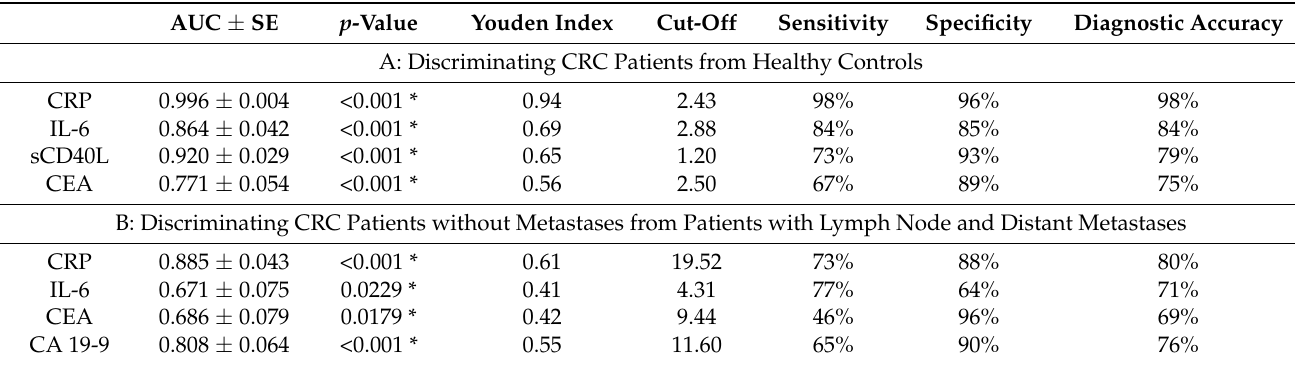
Table 5. Diagnostic utility of inflammatory response biomarkers (CRP, IL-6, and sCD40L) and cancer biomarkers (CEA and CA 19-9) for discriminating CRC patients from healthy controls (A), and for discriminating CRC patients without metastases from patients with lymph node and distant metastases (B).